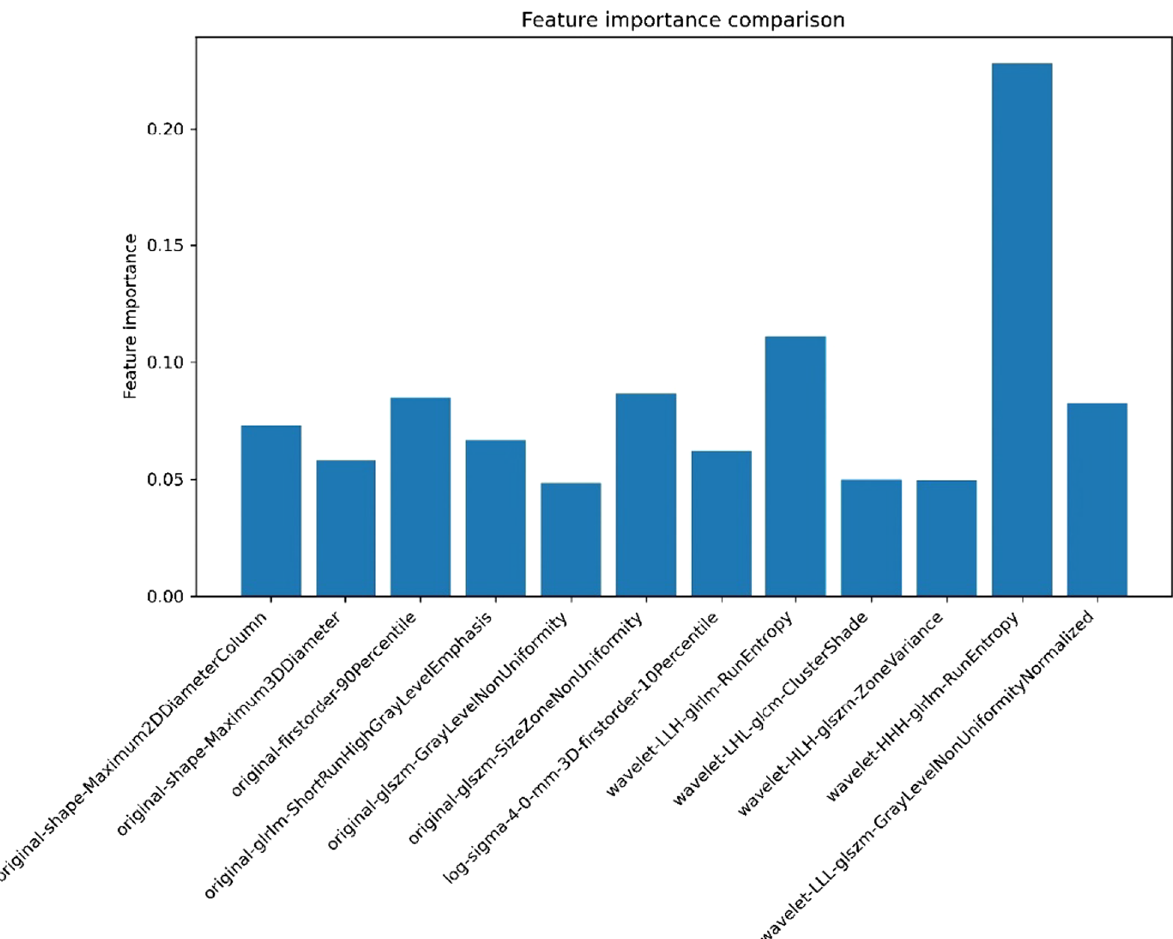
Fig. 4 Importance of the 12 radiomics